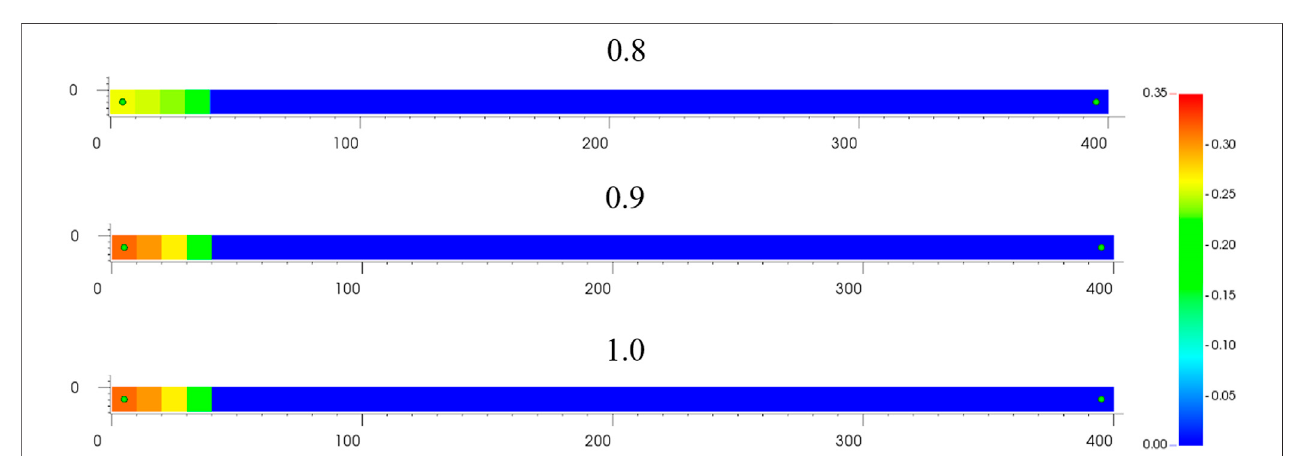
FIGURE 7 | Gas saturation